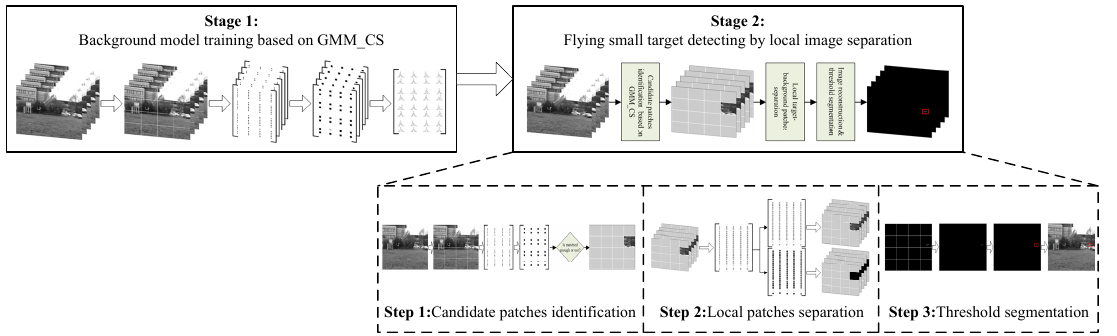
Figure 3. Comprehensive scheme for flying small target